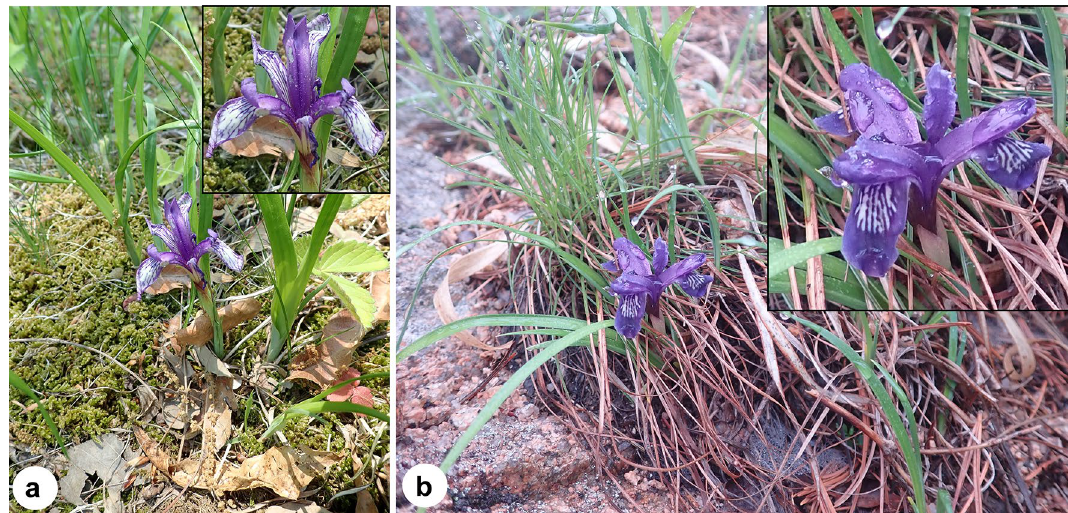
Figure 1. Morphology and habit of Iris species from Korea. (a) I. ruthenica ; (b) I. uniflora . Insets in ( a ) and ( b ) show the enlarged image of the flowers of the investigated species. All photographs were obtained by Tae-Soo